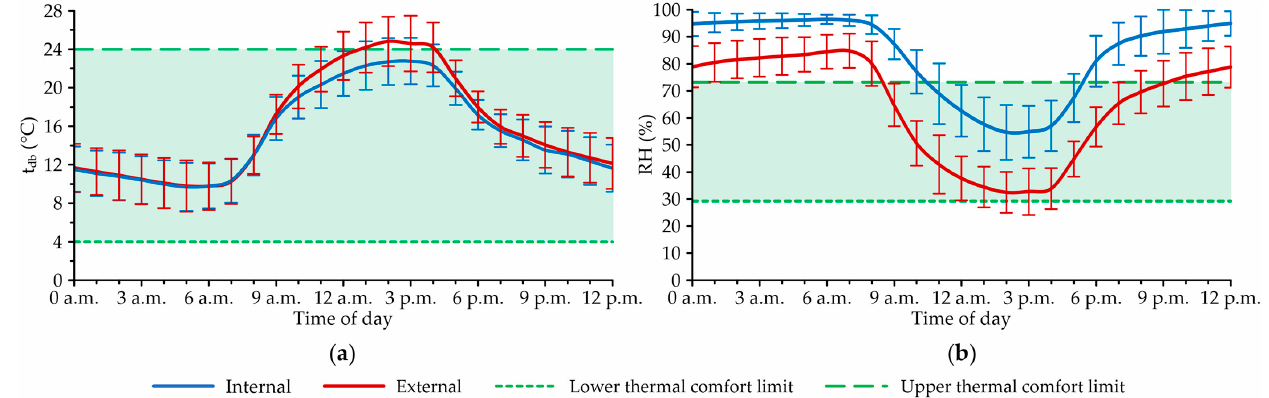
Figure 3. Average hourly profiles, with standard deviations, of ( a ) dry-bulb air temperature (t db , in °C) and ( b ) relative humidity (RH, in %) throughout the day in the internal and external environments of the facility, during the experimental period.